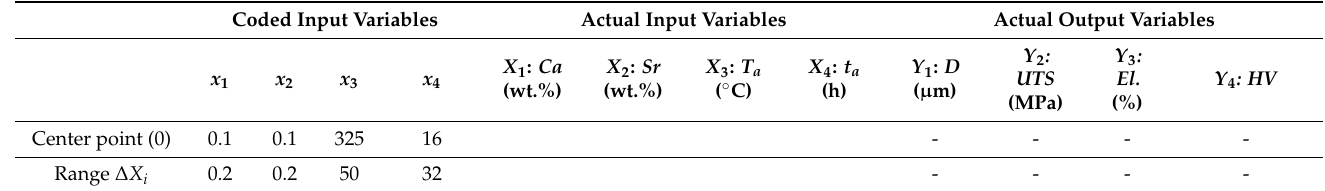
Table A1. The experimental